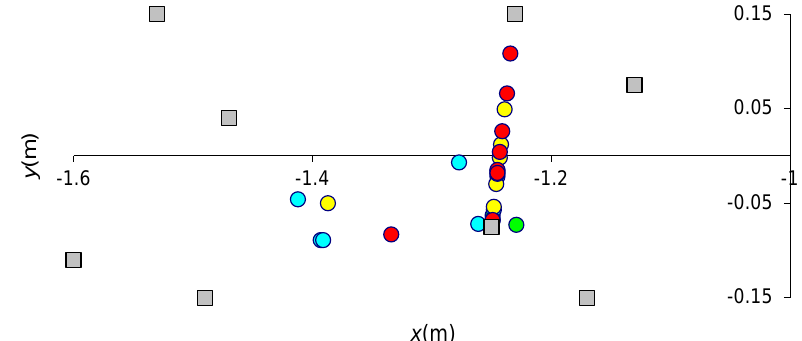
Figure 10. Location of AE sources and AE sensors (numbered gray squares). Adopted reference system (x, y, z) as in Figure 1 and color map as in Figure 9.